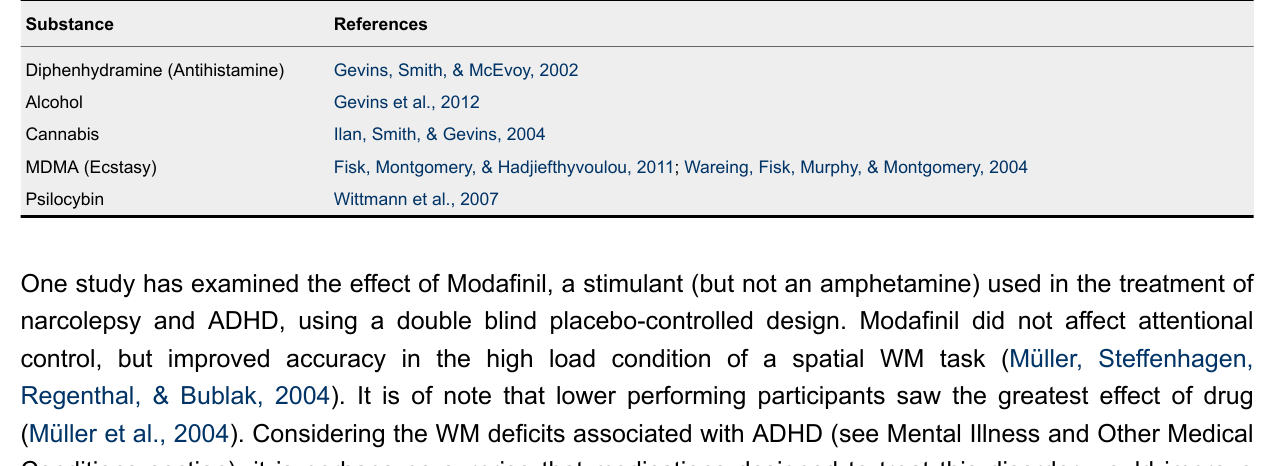
Psychoactive Substances Associated With Impaired WM